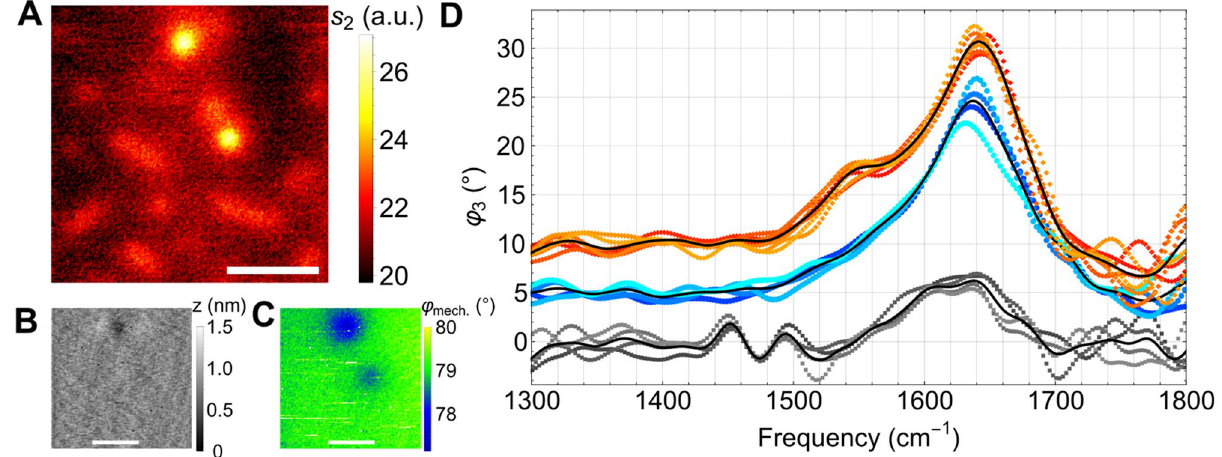
Figure 6. Living E. coli cells characterised by s-SNOM and nano-FTIR, ( A ) infrared amplitude s 2 image of a preparation as in Fig. 5 exhibiting two bright, round cells which also appear in the simultaneously recorded mechanical images of ( B ) topography and of ( C ) mechanical phase φ mech , scale bars 2 µm. ( D ) Nano-FTIR phase φ 3 spectra (data points) with averages (lines, offset 5° each for clarity), taken on bright round cells (black), lengthy cells (red), or between cells (blue) of ( A ), directly prove significantly different spectra, and thus chemical content, when probing a side vs a front location of a cell’s